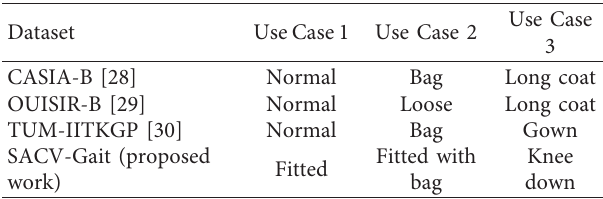
Table 1: Description of Use Cases 1, 2, and 3 in CASIA-B [28], TUM-IITKGP [30], OUISIR-B [29], and SACV.